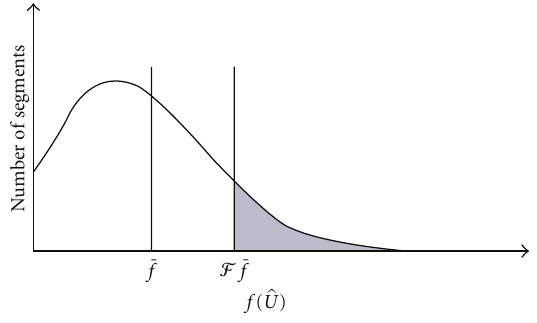
Figure 1: Graphical representation of the filter F and its e ff ect.